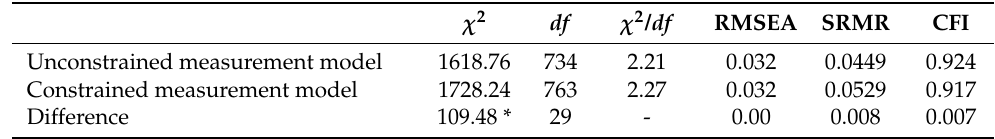
Table 9. Measurement invariance test between the 2019 sample and 2021